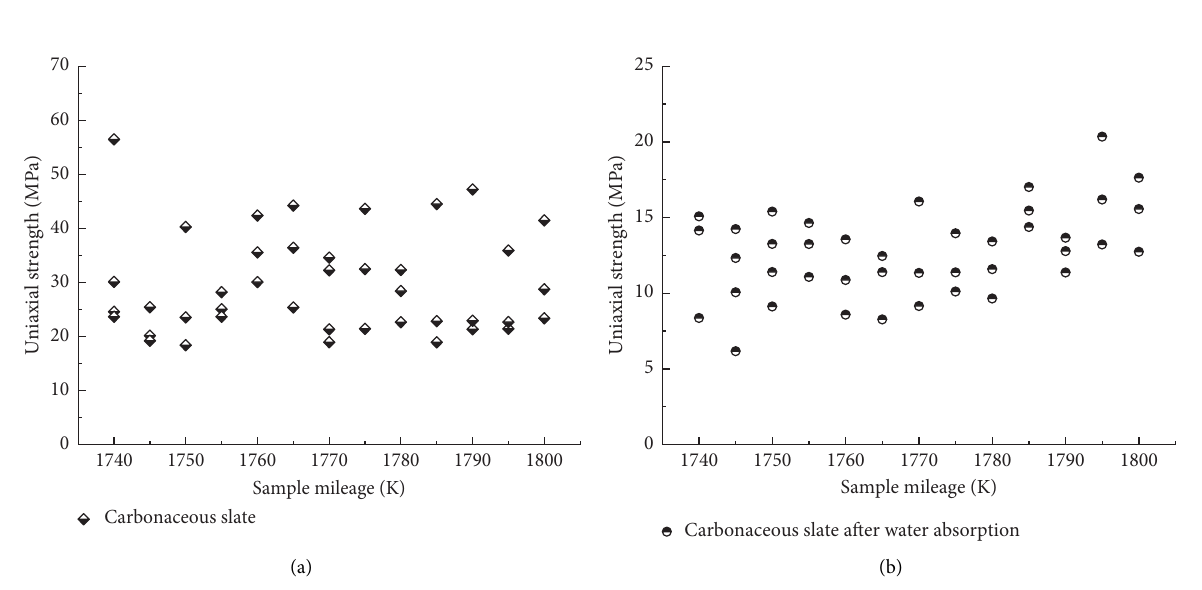
Figure 2: Uniaxial compressive strength of carbonaceous slate in the Muzhailing No. 2 inclined shaft: (a) compressive strength of carbonaceous slate in the natural state and (b) compressive strength of carbonaceous slate after water